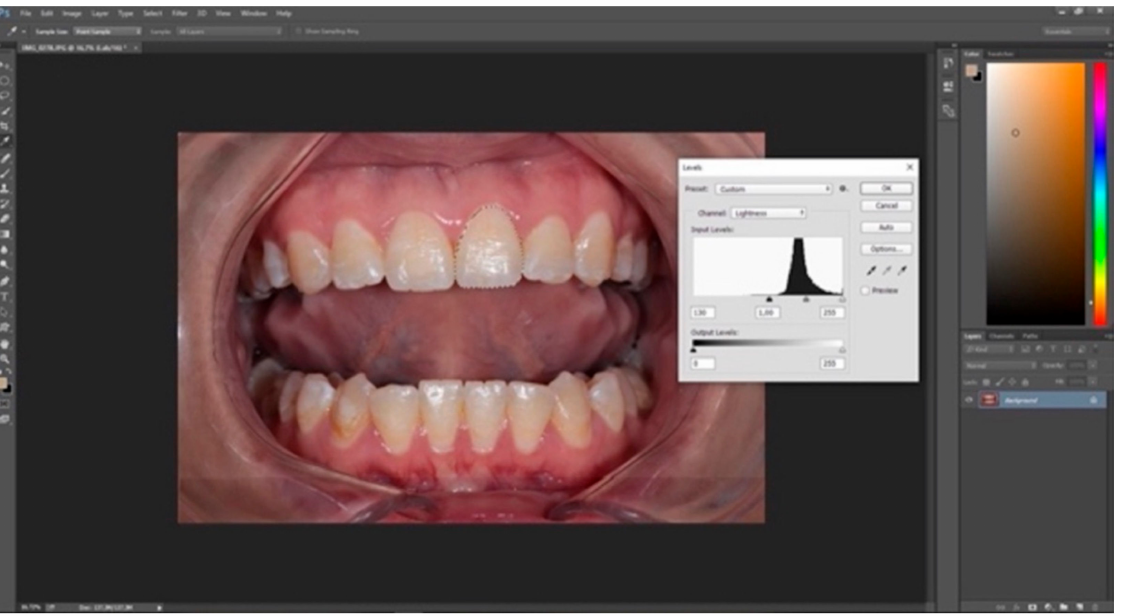
Figure 2. The selection of the tooth to be measured, and the metering of the L* value through the